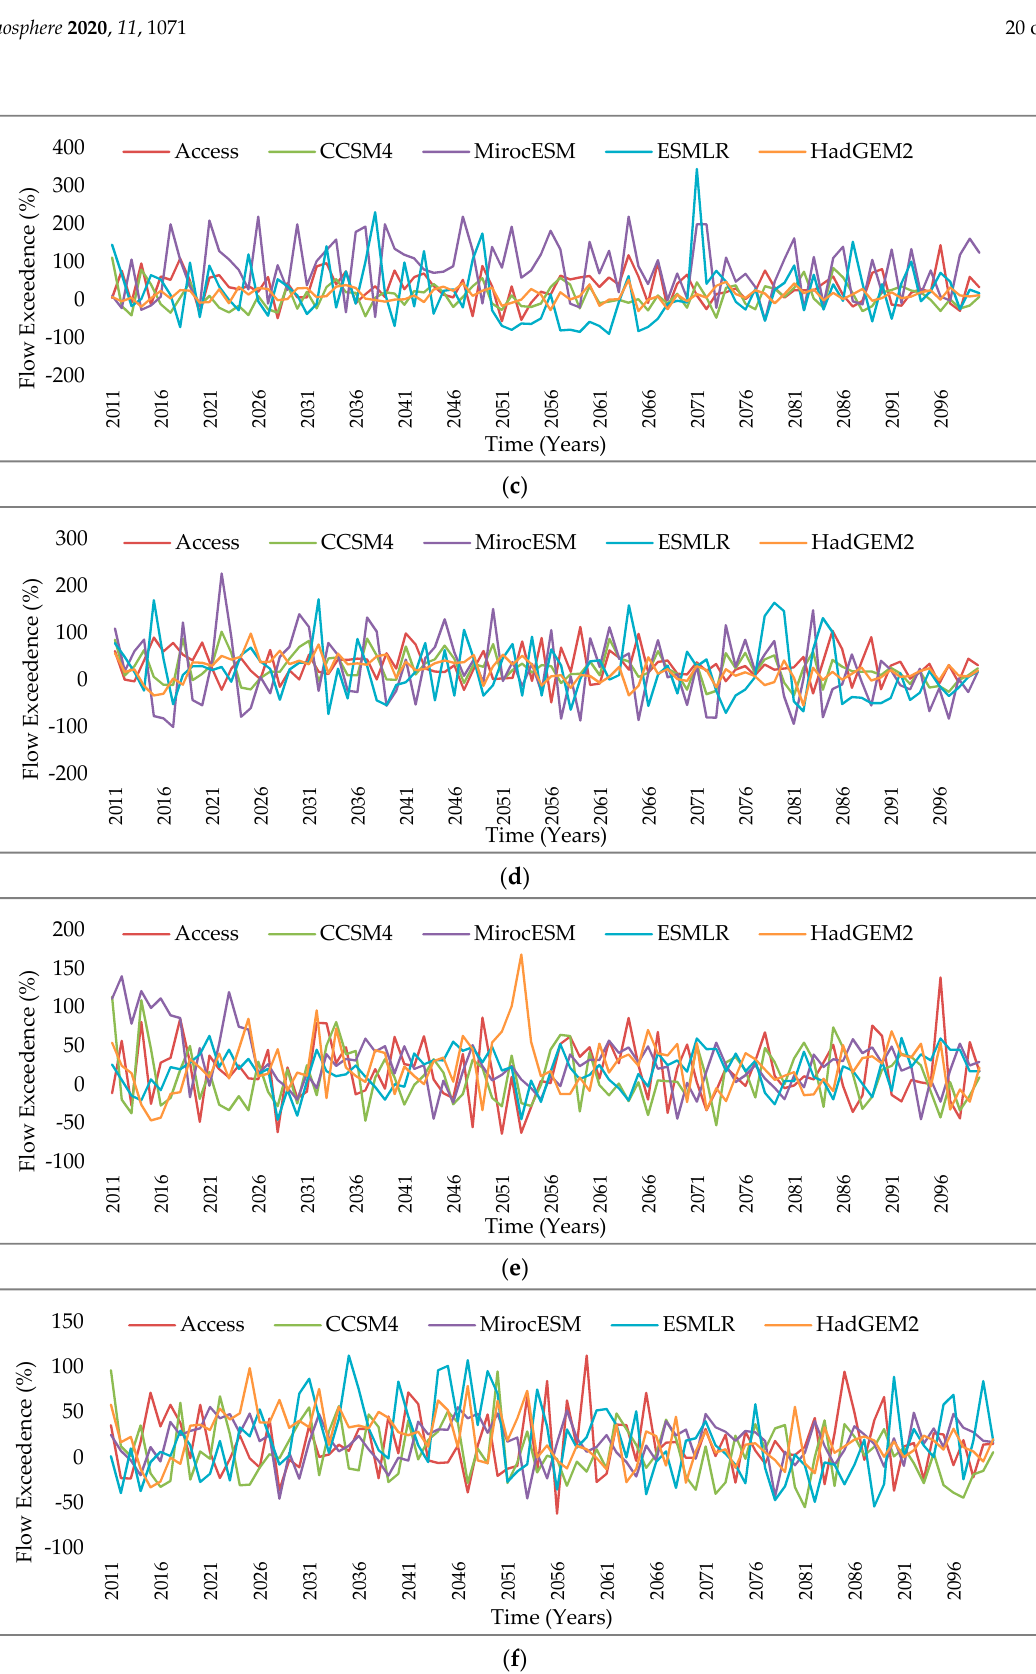
Figure 11. Comparison of different downscaling techniques in regards to average annual percent change in flow ( a ) Change Factor RCP 4.5, ( b ) Change Factor RCP 8.5, ( c ) Linear Scaling RCP 4.5, ( d ) Linear Scaling RCP 8.5, ( e ) Distribution Mapping RCP 4.5, and ( f ) Distribution Mapping RCP 8.5.